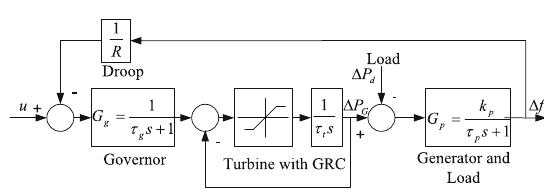
Fig. 7 Single-area power system with GRC block